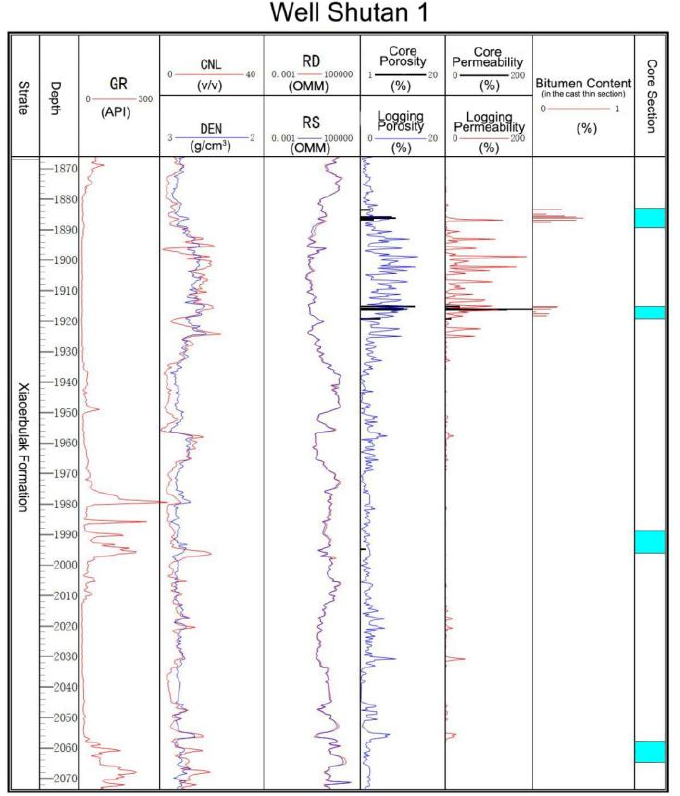
Figure 7. Porosity, permeability and bitumen content of Xiaoerblak Formation in Well Shutan 1.